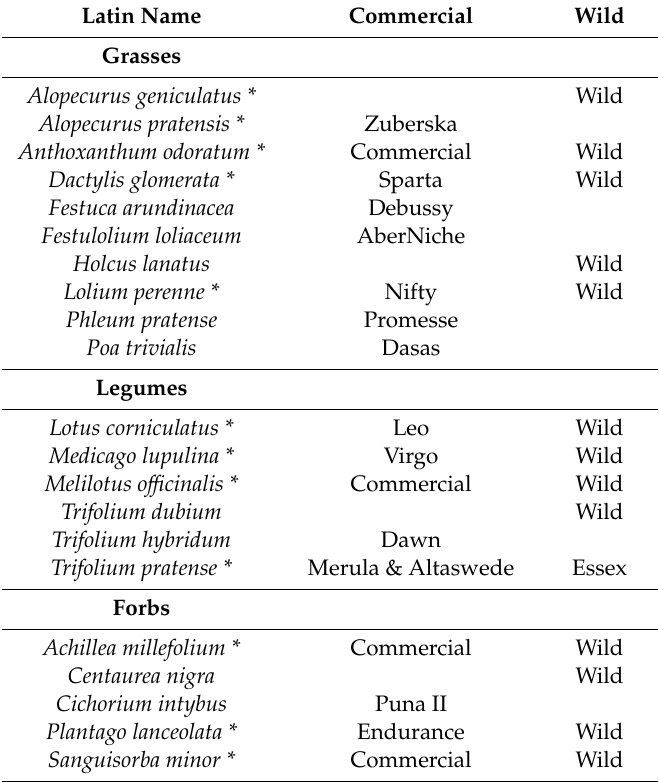
Table 1. Species of grasses, legumes and forbs grown in the pot experiment. A cultivar name is given if one was available. Additionally shown is whether the species is commercially available or